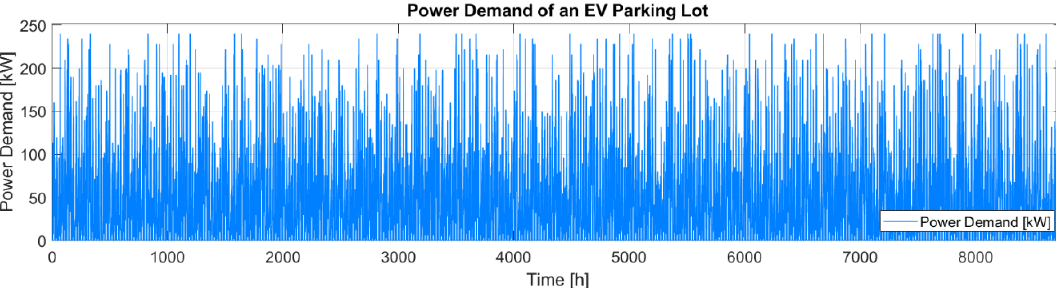
Figure 5. Estimated power demand of the EVPL in Montreal.